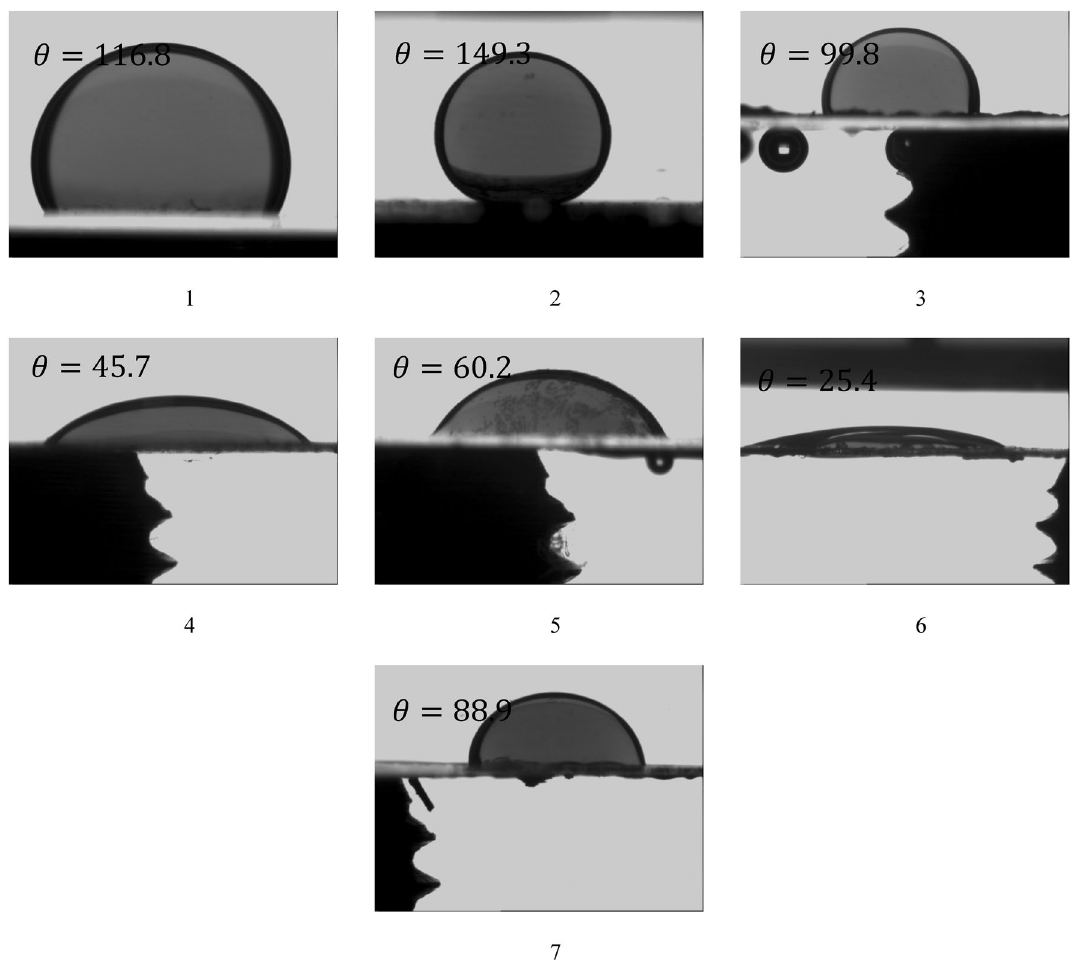
Fig. 11 Contact angle measurement for Kuh-e-Mond asphaltene samples in different